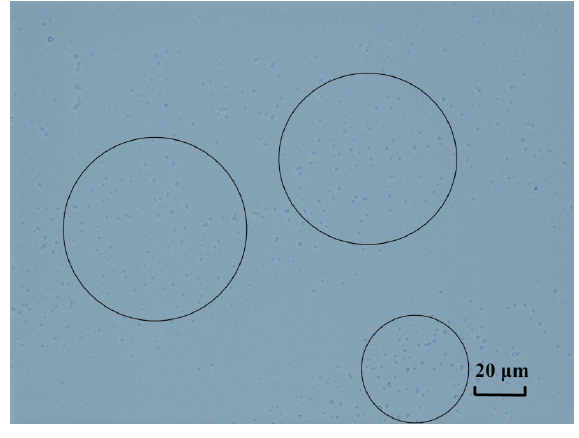
Figure 10. Nanobubbles in the solution with HC assistance.